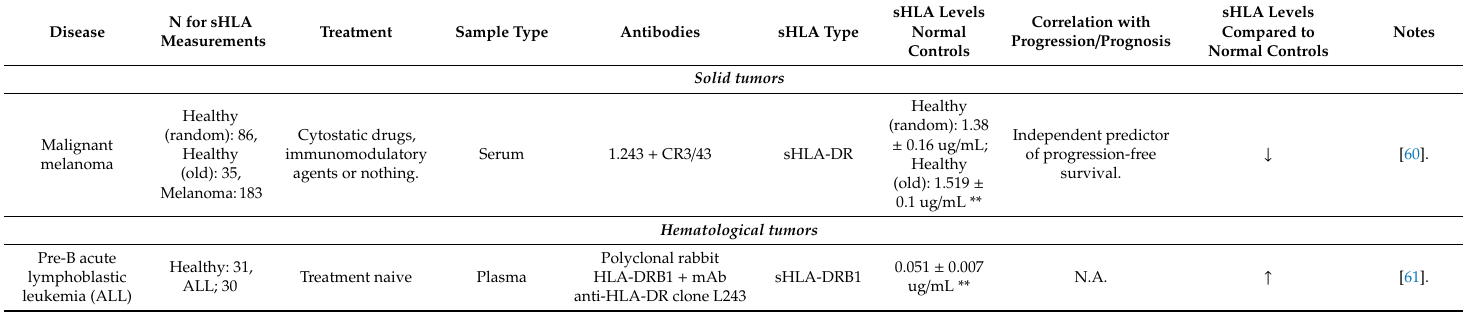
Table 4. Soluble HLA Class II Molecules in Malignancy . Levels of soluble HLA class II molecules in solid and hematological tumors. All studies measured sHLA levels by ELISA, unless indicated otherwise under Notes. ** = mean ±